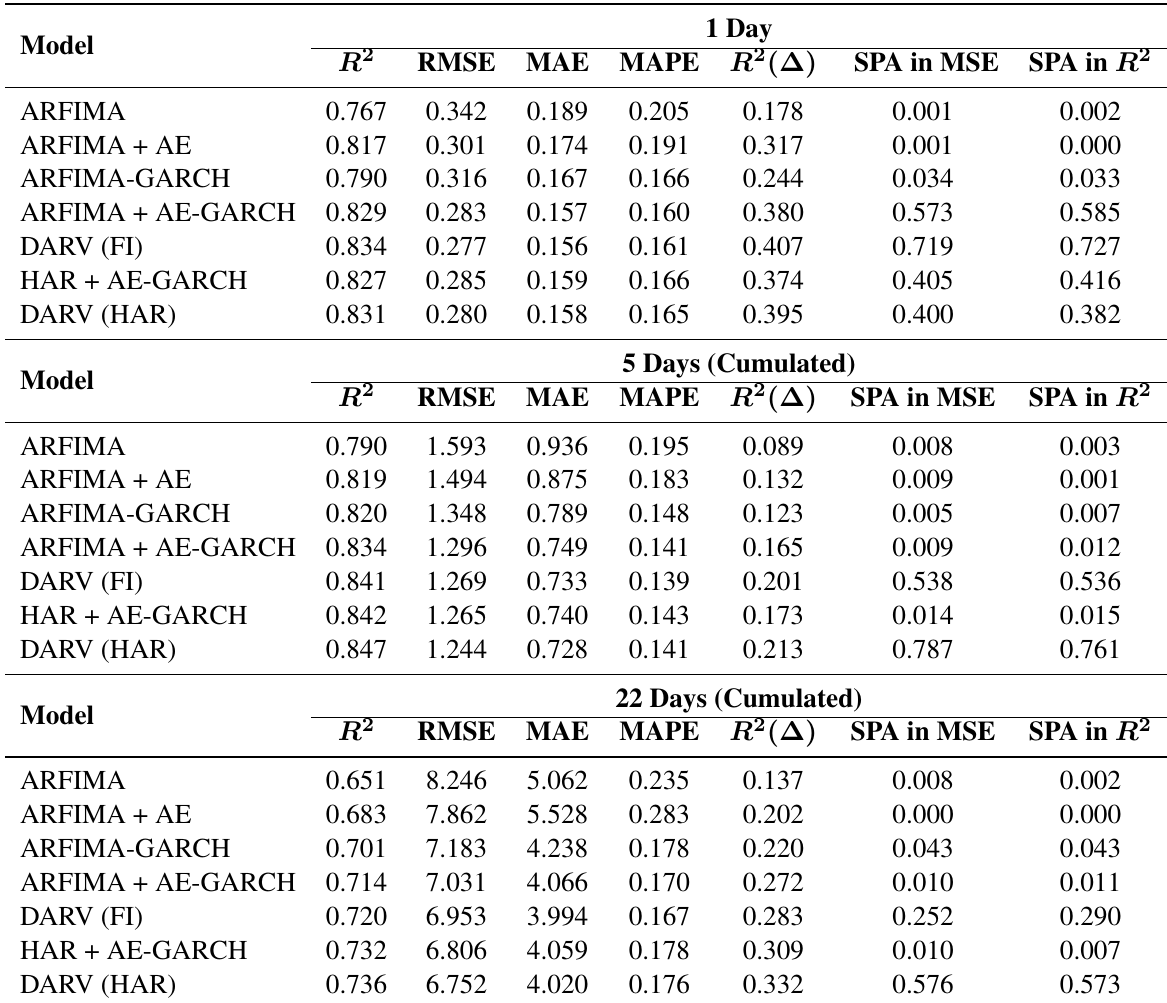
Table 7. Forecasting results: S&P